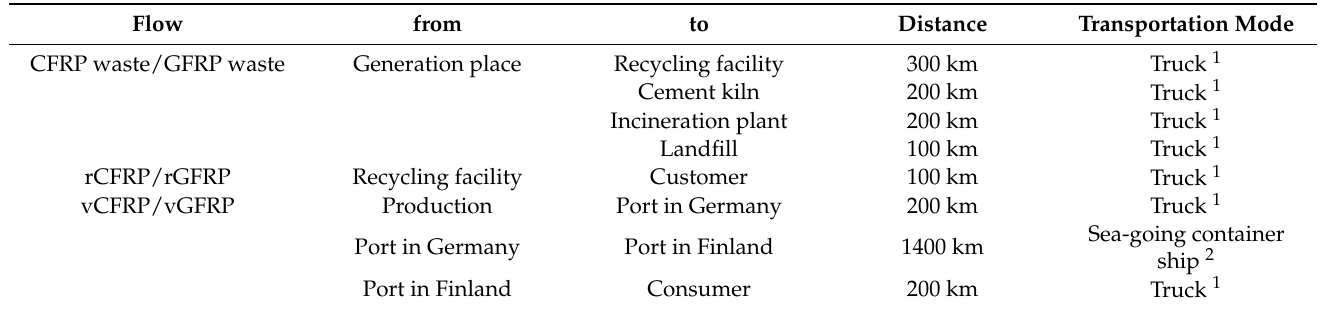
Table 3. Transportation distances and